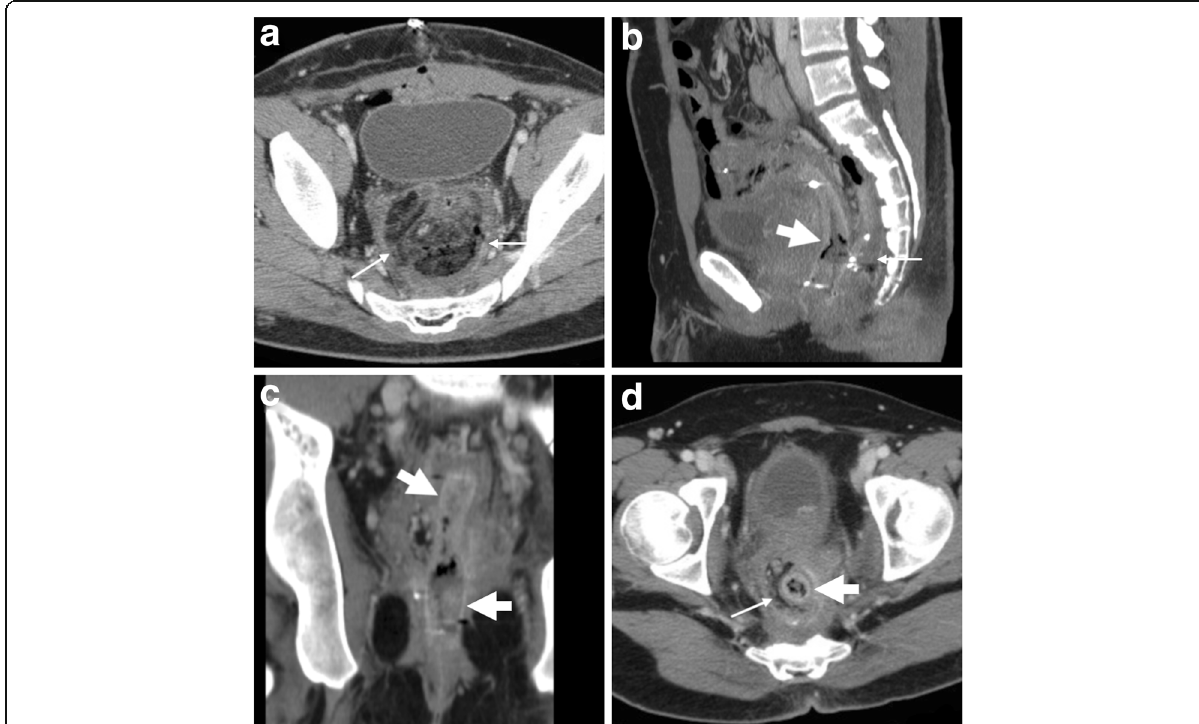
Fig. 13 Use of bioabsorbable stent to manage a chronic anastomotic fistula following anterior rectal resection. After drainage of a perianastomotic abscess (not shown), CT ( a ) showed the persistence of perianastomotic inflammation (thin arrows) with gas bubbles (note the close similarity to Fig. 11b). Repeated CT ( b – d ) showed decreased perianastomotic inflammation (thin arrows) compared to a and confirmed correct placement of the bioabsorbable stent (thick arrows) which appears as a tubular structure with soft-tissue attenuation, best visible using MIP reconstructions ( b